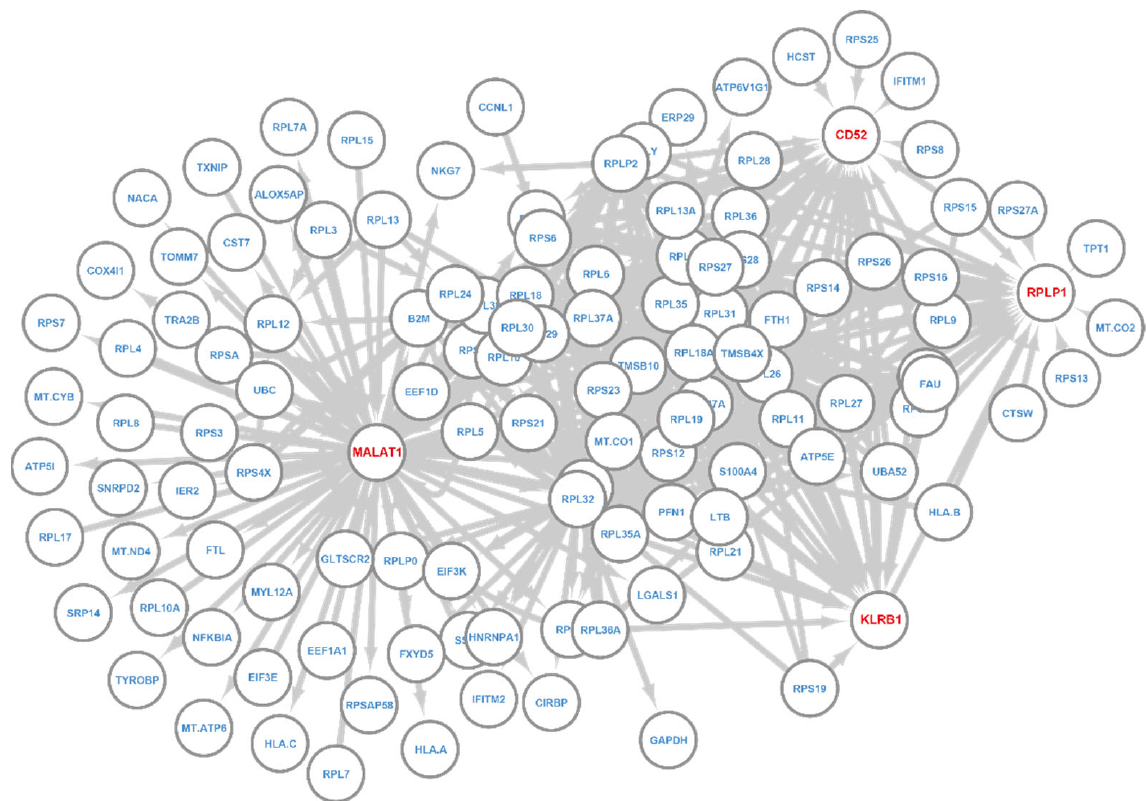
Figure 6. T ‐ GEM regulatory network for NK cell. Nodes are informative genes and their associated Key genes. Links go from Key to Query genes. Genes with red color are hub genes.